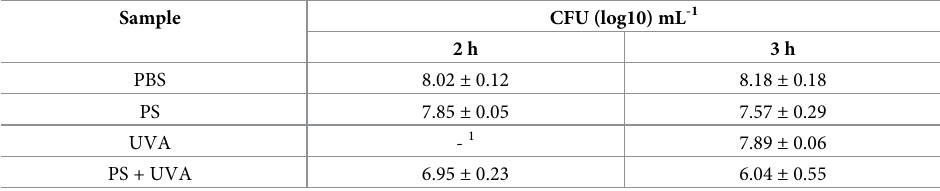
Table 2. Effect of UVA radiation on E . coli using pheomelanin nanoparticles.